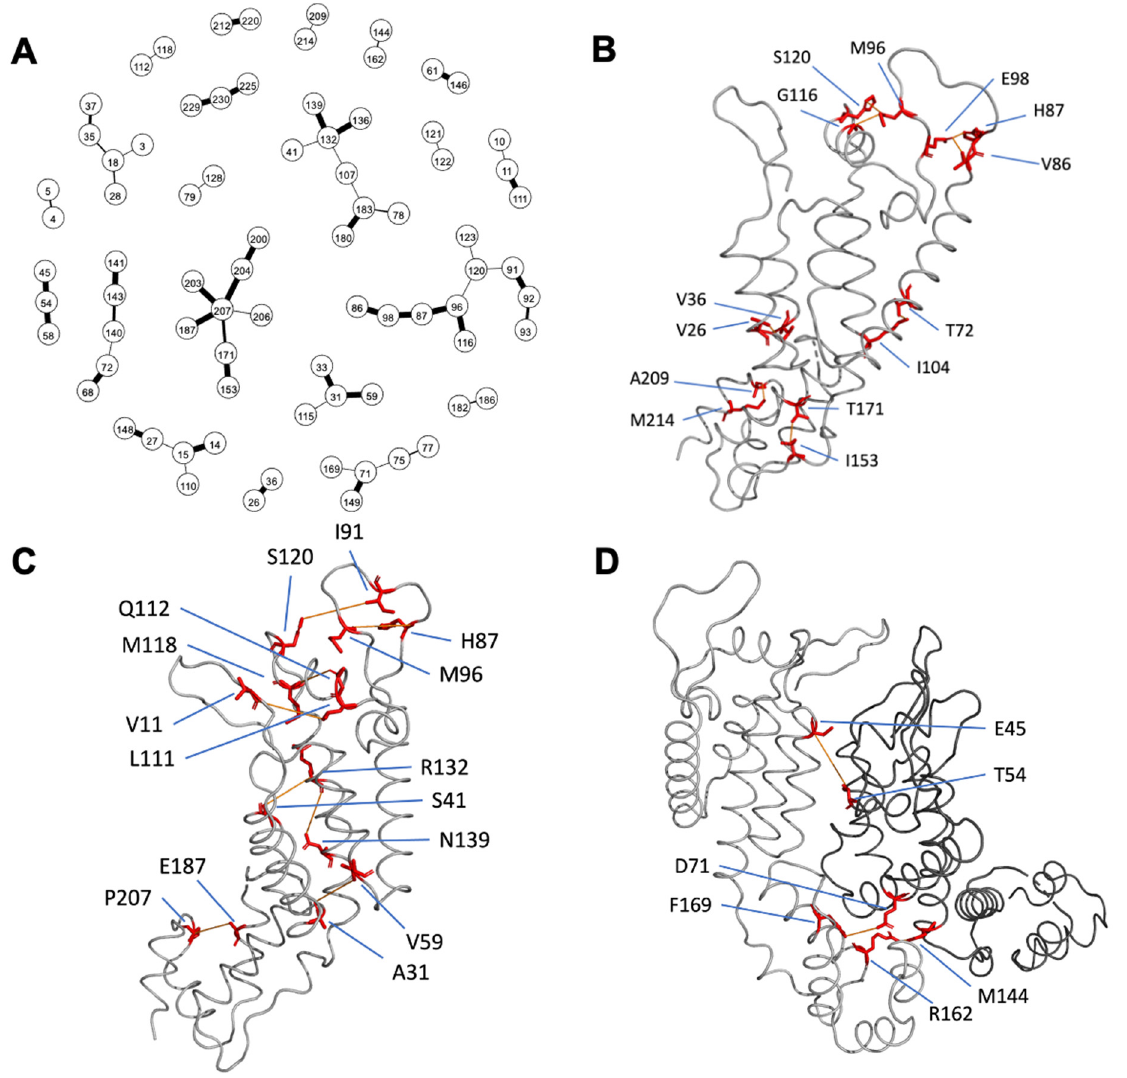
Figure 5. Correlation of amino acid positions. ( A ) Graphical network diagram of all significantly correlated positions. The edge thickness is proportional to the probability of interaction. ( B ) Correlated positions that were ≥ 5 positions apart and were within 5 angstroms in the same monomer, residues were linked in red lines by closest atoms. ( C ) Correlated positions that were ≥ 5 positions apart and between 5 and 10 angstroms in the same monomer. ( D ) Correlated positions which that were ≥ 5 positions apart and within 10 angstroms between adjacent monomers in a hexamer.